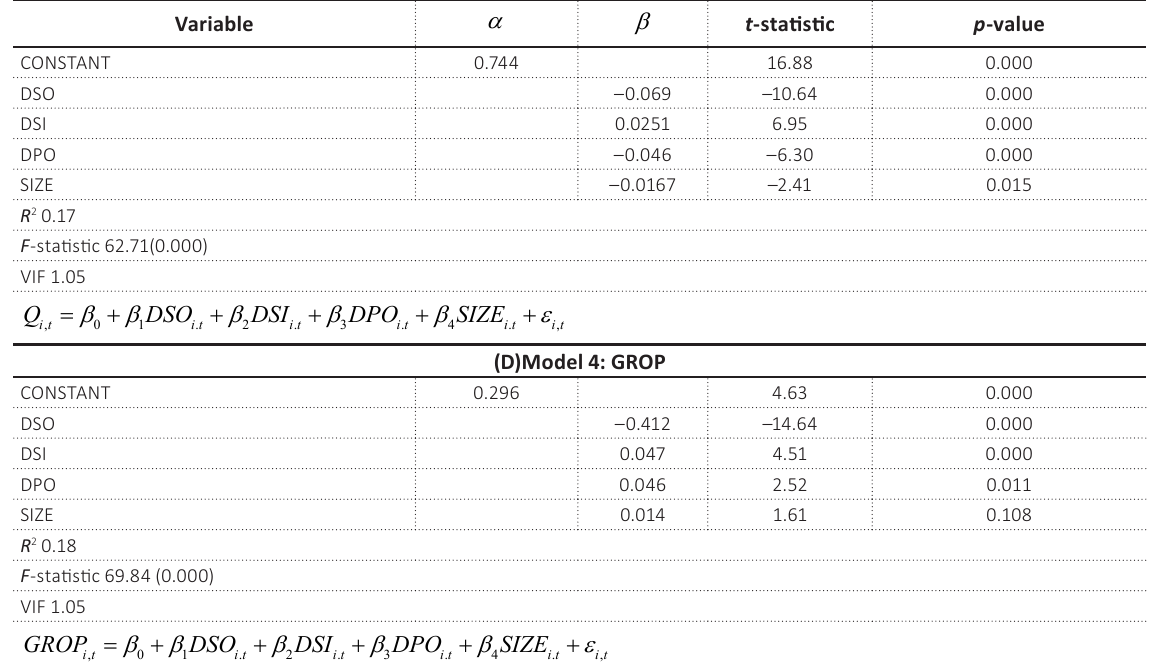
(C)Model 3: Tobin’s